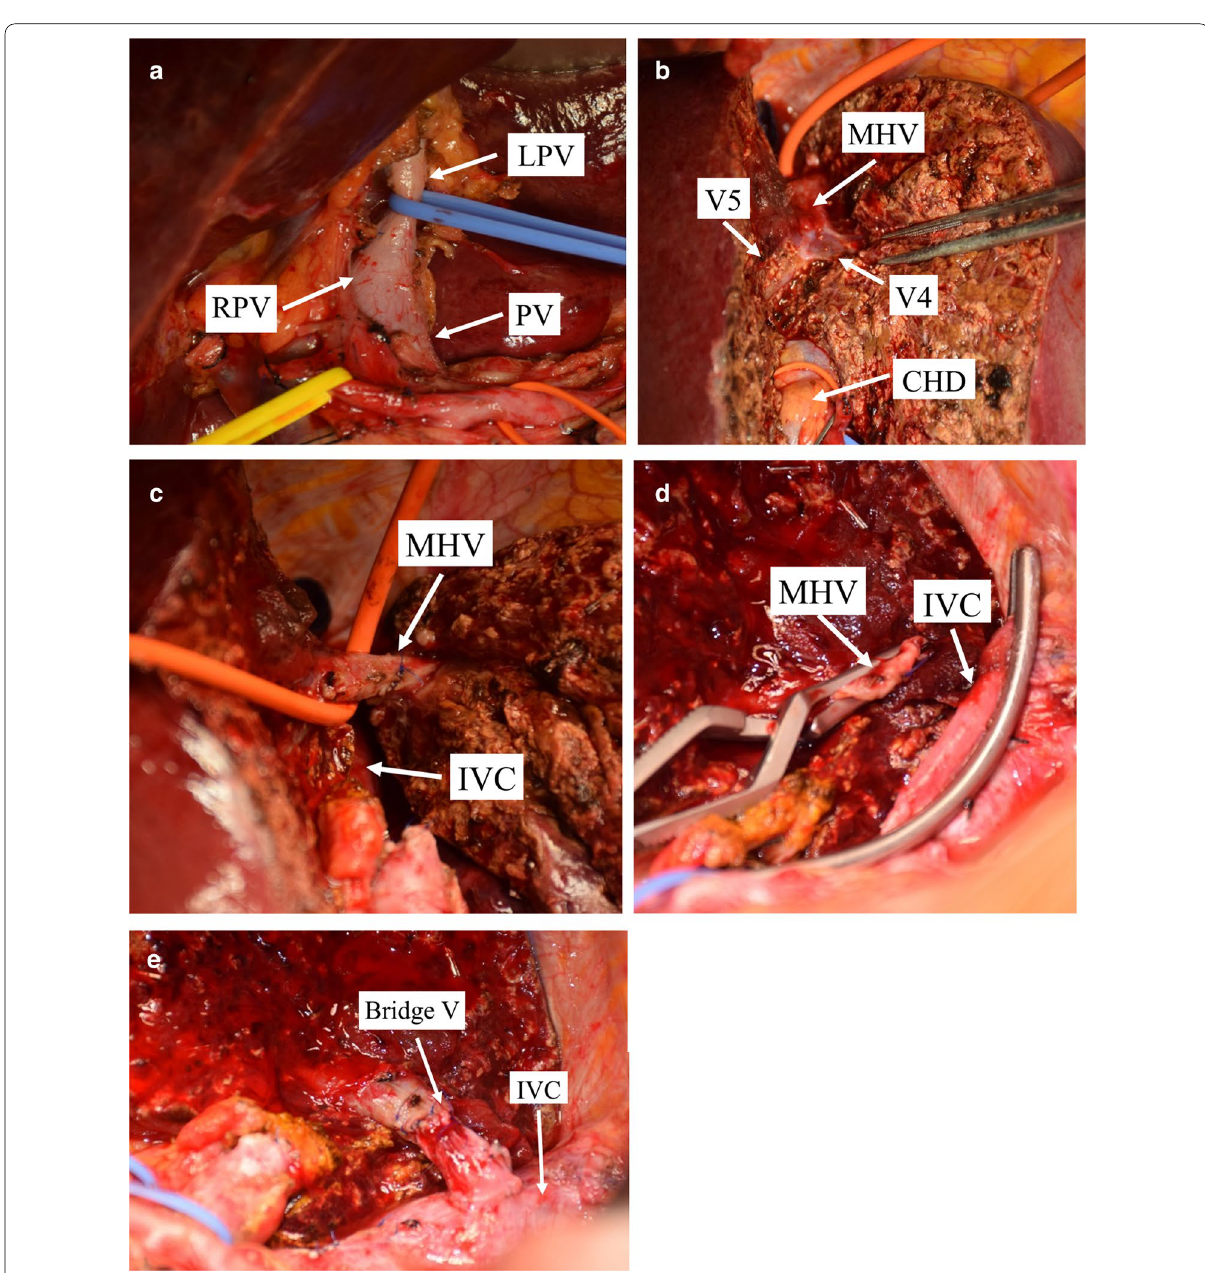
Fig. 10 Intraoperative vascular operation: a dissected the first hepatic hilum, showing the left and right branches of the portal vein. b The trunk of middle hepatic vein and its branches. c Cut off the branch of the segment 4 originating from the middle hepatic vein. d The middle hepatic vein and the left hepatic vein were cut off from the root. The left liver lobe and the Spiegel lobe were removed to expose the inferior vena cava. e Using the left main branch of the portal vein as a vein graft to reconstruct the middle hepatic vein. LPV left portal vein, RPV right portal vein, PV portal vein, MHV middle hepatic vein, CHD common bile duct, IVC inferior vena cava, Bridge V bridge